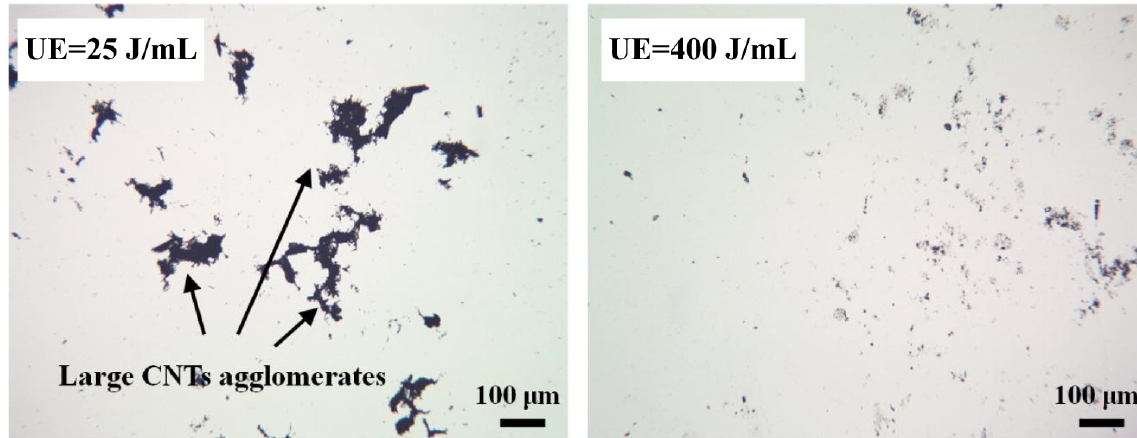
Figure 2: Optical microscope images of CNT suspensions at different ultrasonication power [72]